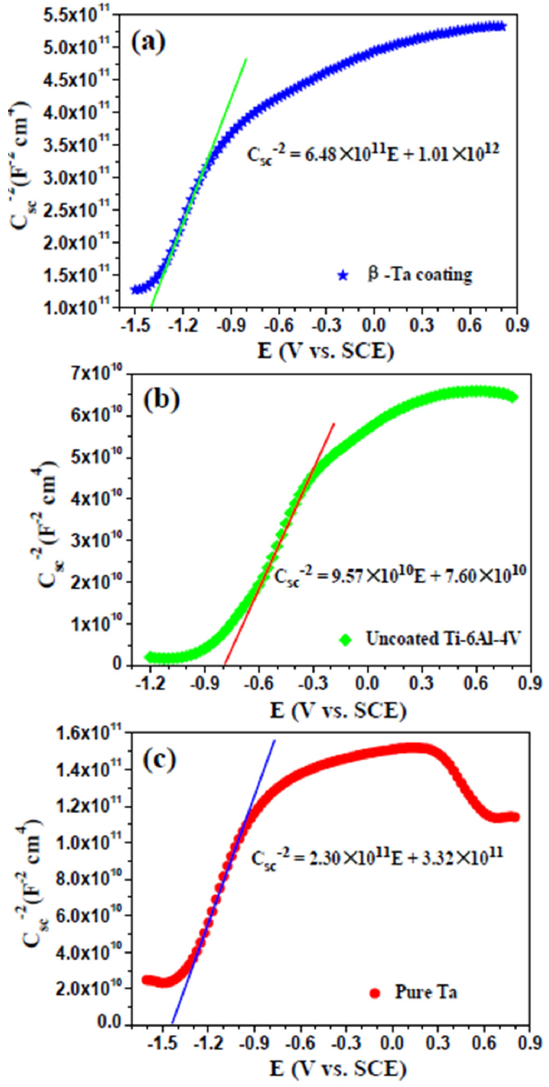
Figure 9. Mott ‐ Schottky plots for: ( a ) the β‐ Ta coating; ( b ) uncoated Ti ‐ 6Al ‐ 4V; and ( c ) commercially Figure 9. Mott-Schottky plots for: ( a ) the β -Ta coating; ( b ) uncoated Ti-6Al-4V; and ( c ) commercially pure Ta after potentiostatic polarization at 0.8 V for 1 h in Hank’s solution at 37 ◦ C. Often, the thickness of the space charge layer scales directly with that of the passive